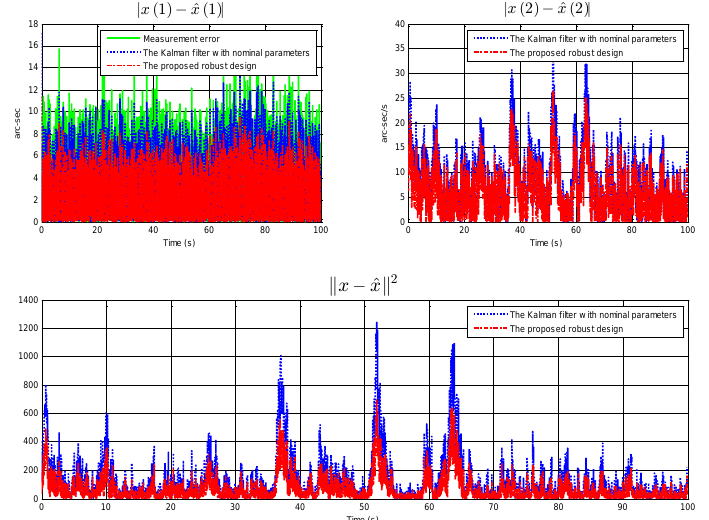
Figure 4. Comparison of estimation errors between SKF and the proposed robust design.